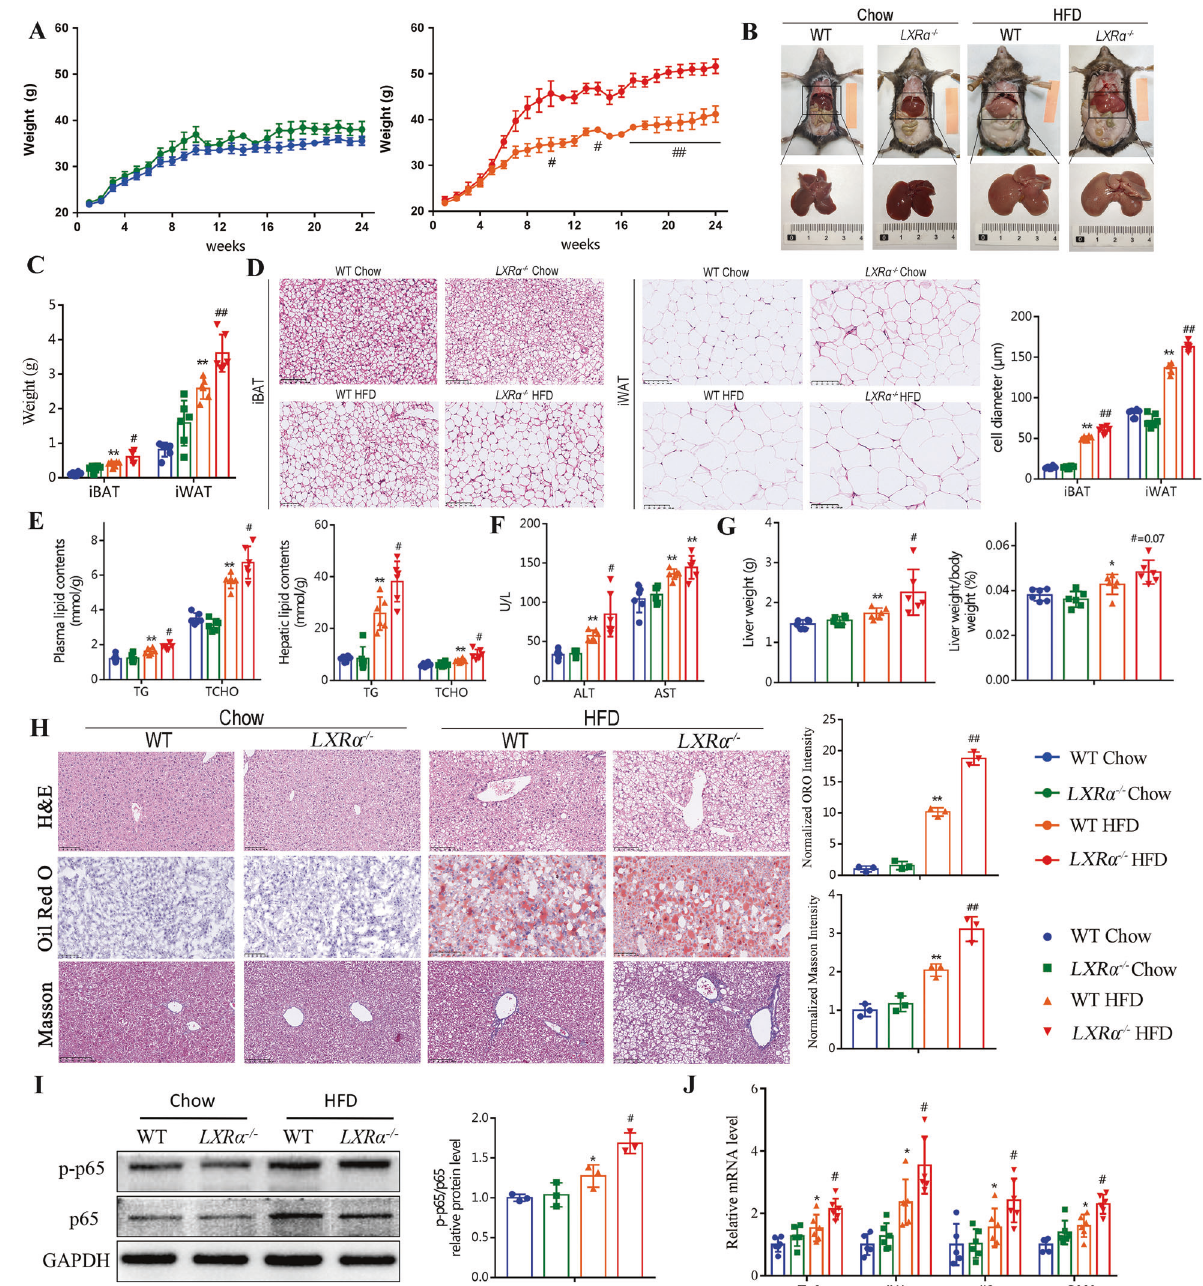
Fig. 2 LXR α de fi ciency aggravates HFD-induced obesity and related comorbidities. Mice were randomly assigned to four groups: WT Chow, LXR α − / − Chow, WT HFD, LXR α − / − HFD, and used for the following assays: A Bodyweight (weekly) ( n = 6). B Representative liver and adipose tissue photos. C Weight of iBAT and iWAT ( n = 6). D Representative images of H&E staining of iBAT and iWAT. Adipocyte diameter was calculated. Scale bar, 100 µm. E Plasma and hepatic triglyceride (TG) and cholesterol (CHOL) levels ( n = 6). F Plasma ALT and AST levels ( n =